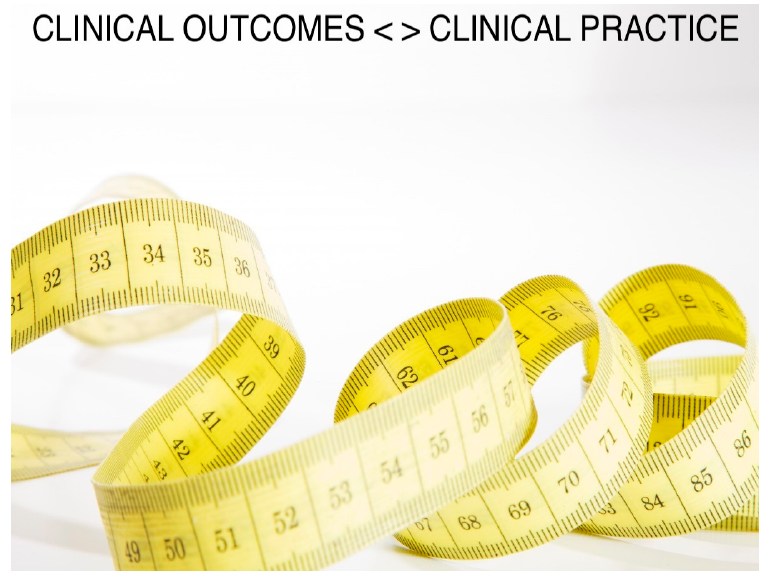
Figure 1. First photovoice: relationship between ‘palpatory findings’ and ‘clinical practice’.